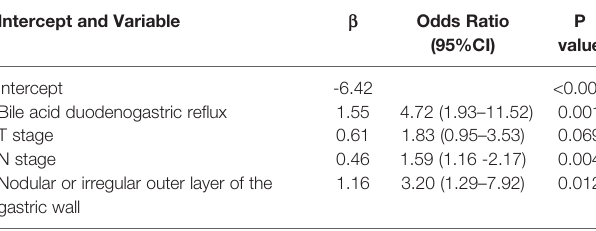
TABLE 3 | Multivariate analysis of risk factors for the clinical model.